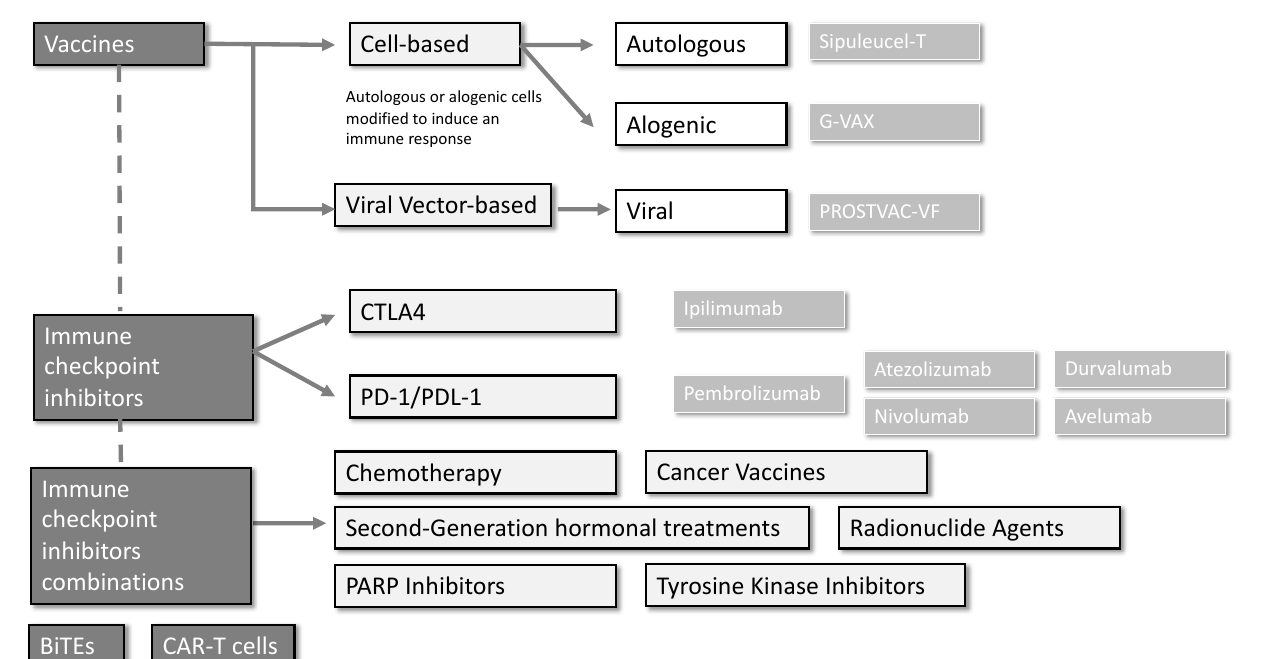
Figure 1. Immunotherapy treatment strategies in metastatic castration-resistant prostate cancer.